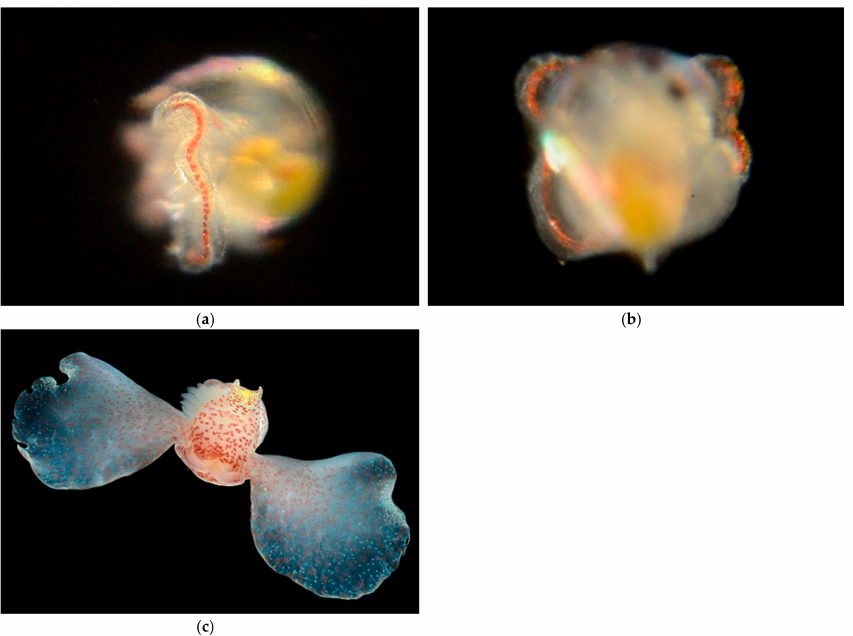
Figure 18. Family Gastropteridae . Pacific Batwing Seaslug Gastropteron pacificum . ( a , b ) Veliger CCDB 31729 A07 from Newport Beach Harbor entrance. ( a ) lateral, ( b ) dorsal. ( c ) adult © Gustav Paulay. https://cdn.floridamuseum.ufl.edu/IZ/04ff1938-4872-41fd-9a4a-270ef0c5cc7e/ (accessed on 1 January 2022).